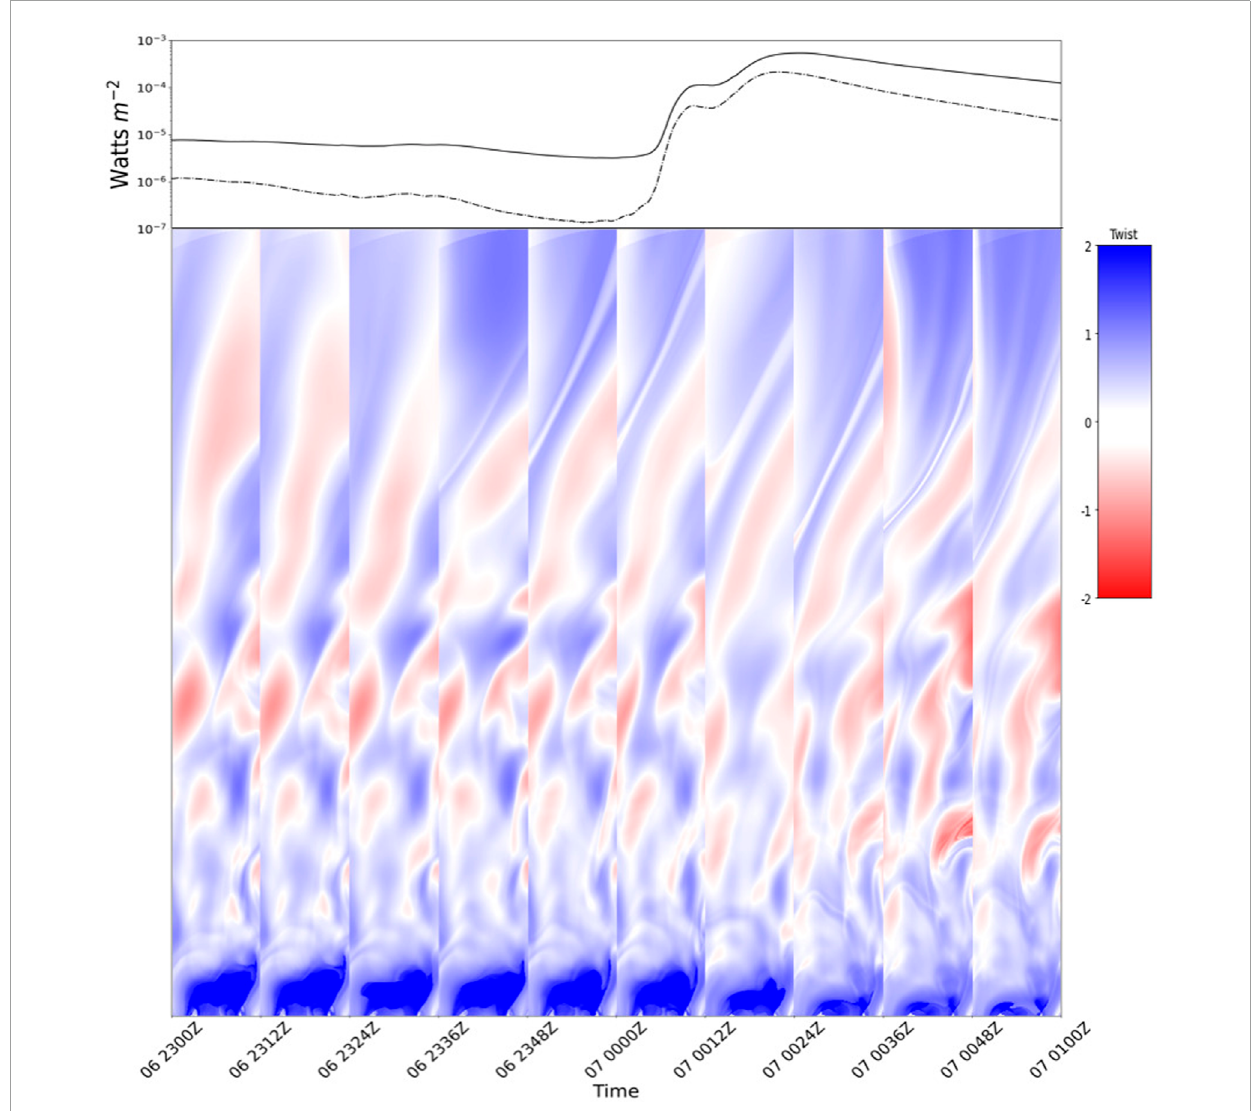
FIGURE 10 GOES measured X-ray flux combined with the vertical twist maps along the OR from 1 h before through 1 h after the X5.4 solar flare. The solid line represents the XRS long (1.0—8.0 Å) channel; the dashed line represents the short (0.5—4.0 Å)